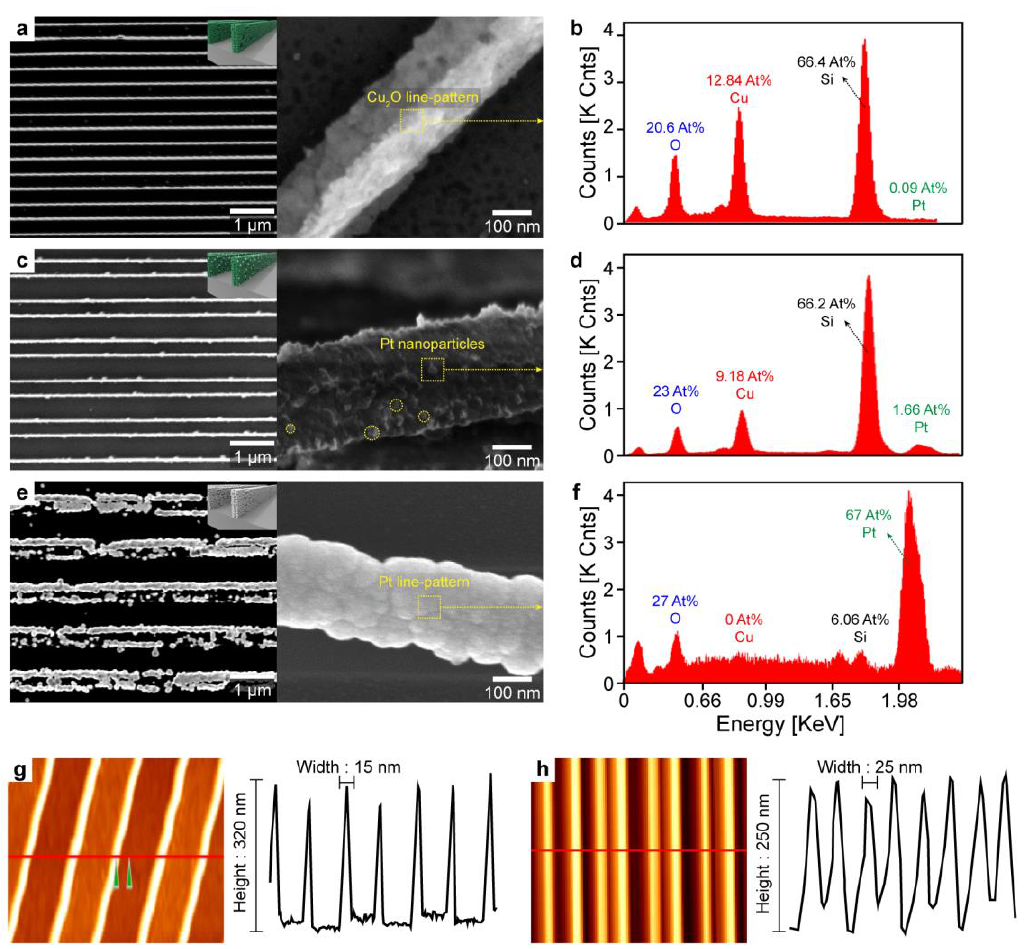
Figure 2. Characterization of fabricated Cu 2 O, Pt/Cu 2 O, and Pt sensing channel. SEM image of the fabricated pattern array for ( a ) pristine Cu 2 O, ( c ) optimized Pt-doped Cu 2 O, and ( e ) completely reacted Pt. ( b – f ) EDS point analysis of each channel. ( g – h ) AFM depth and width profiles show ultrathin line channel and no disruption of the pattern after Pt doping.